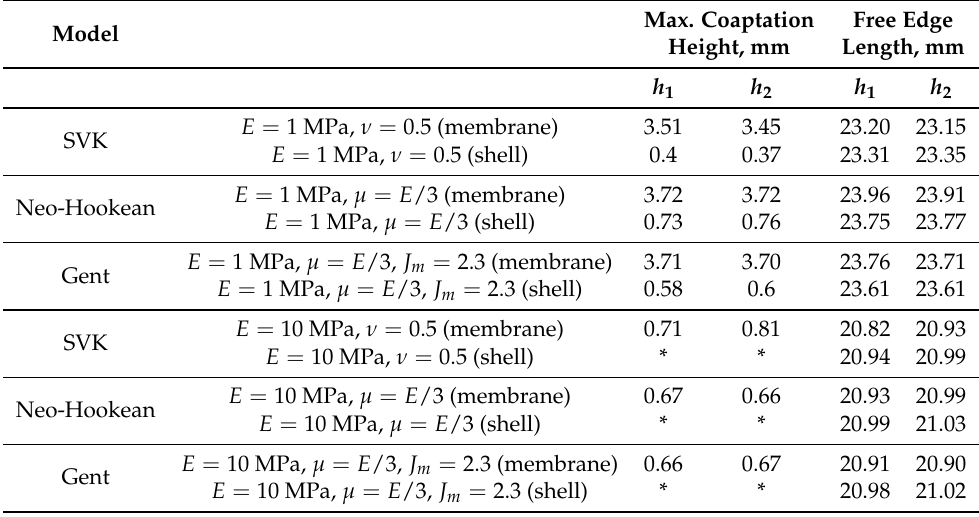
Table 1. Comparison of maximal coaptation heights and free edge lengths computed by differ- ent models for two meshes with mesh sizes h 1 and h 2 , respectively. Symbol * denotes the lack of coaptation.